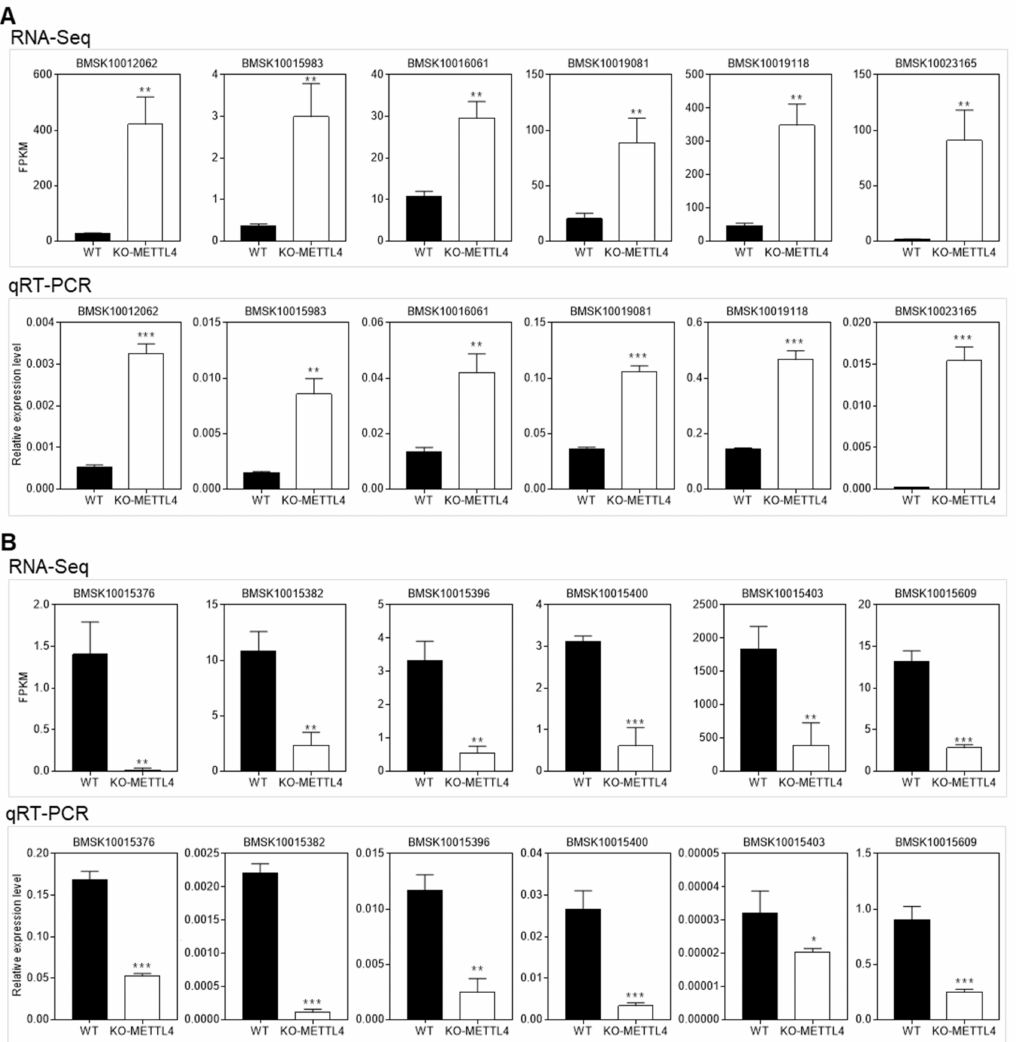
Figure 4. qRT-PCR verification of the RNA-Seq data. ( A ) qRT-PCR was used to examine the up- regulated DEGs from RNA-Seq. ( B ) qRT-PCR was used to examine the down-regulated DEGs from RNA-Seq. Each sample was repeated in triplicate and all data were presented as the mean ± standard deviation (SD). A student’s t-test was used to evaluate statistical significance (* p < 0.05, ** p <0.01, and *** p <